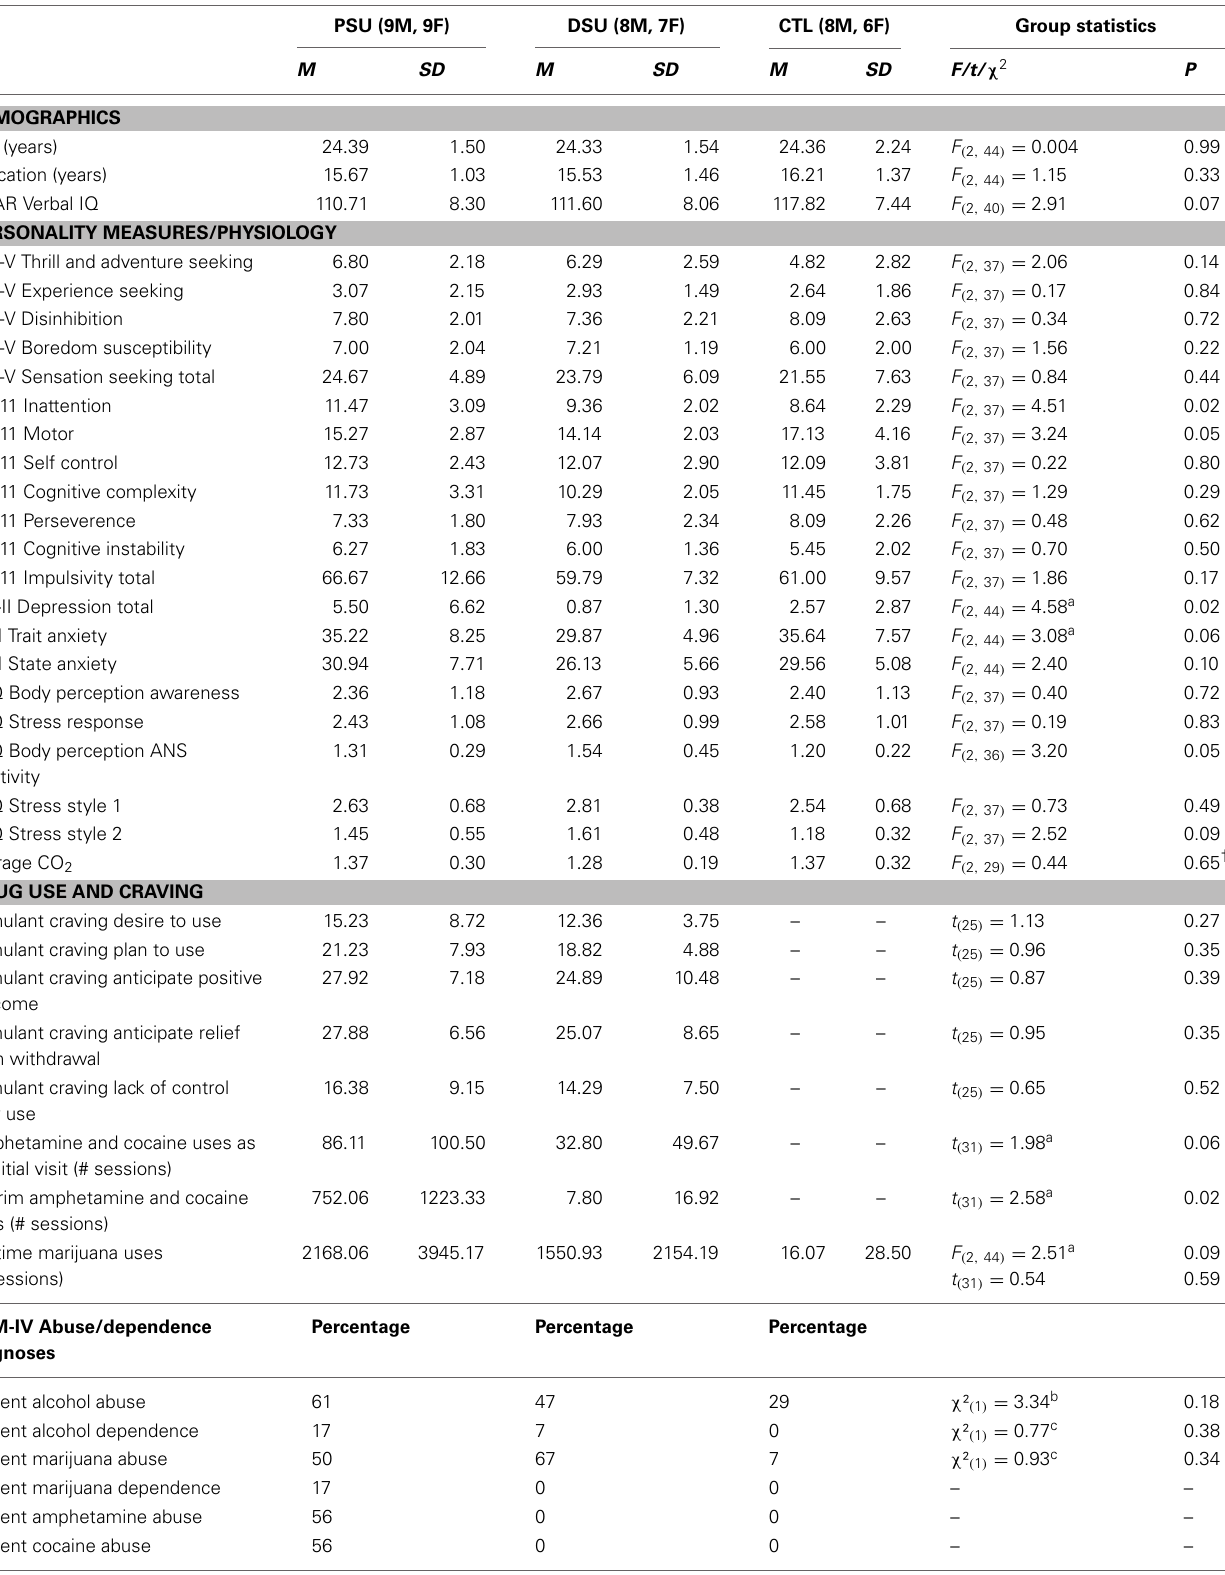
Table 1 | Group differences in demographics, personality, and drug